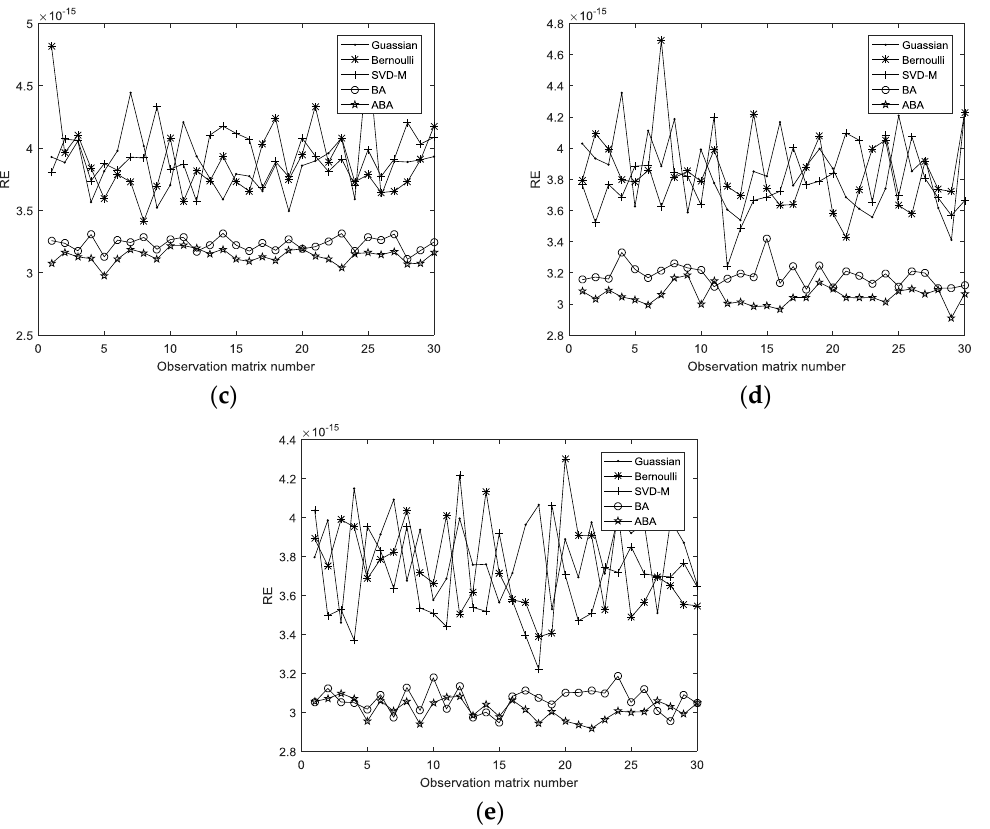
Figure 4. Reconstruction error of each algorithm to signal-1 with different compression ratio: ( a ) Rate = 0.3; ( b ) Rate = 0.35; ( c ) Rate = 0.4; ( d ) Rate = 0.45; ( e ) Rate = 0.5.